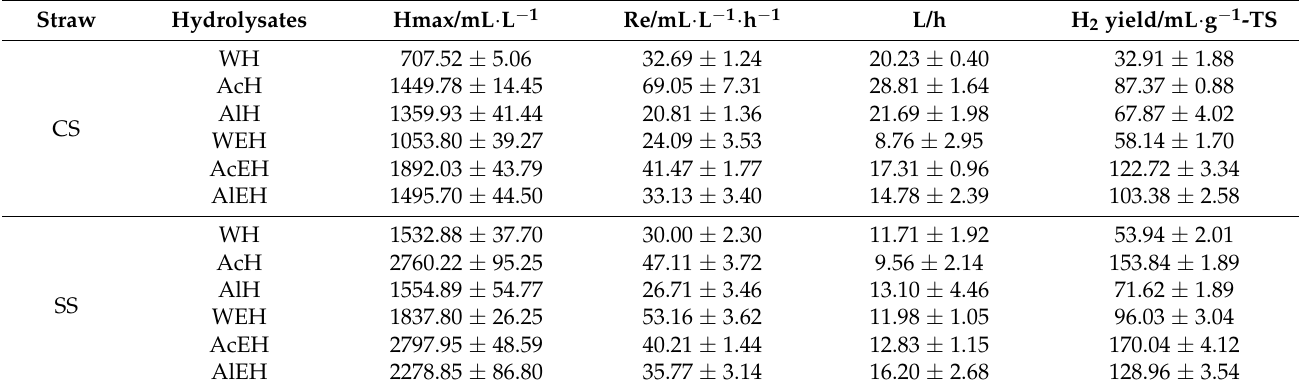
Table 3. Parameter fitting of photo-fermentation of SS